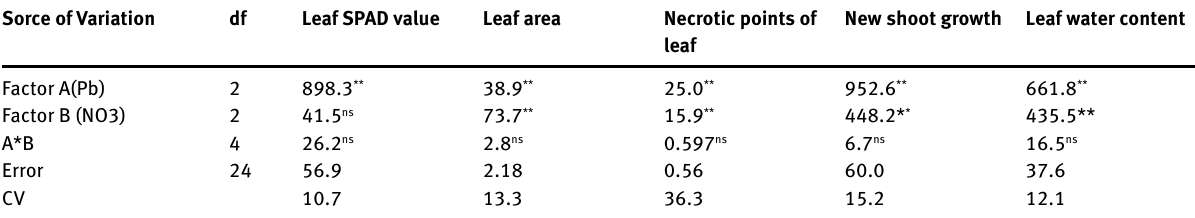
Table 2: Analysis of variances of some growth factors of Judas tree plants Sorce of Variation df Leaf SPAD value Leaf area Necrotic points of